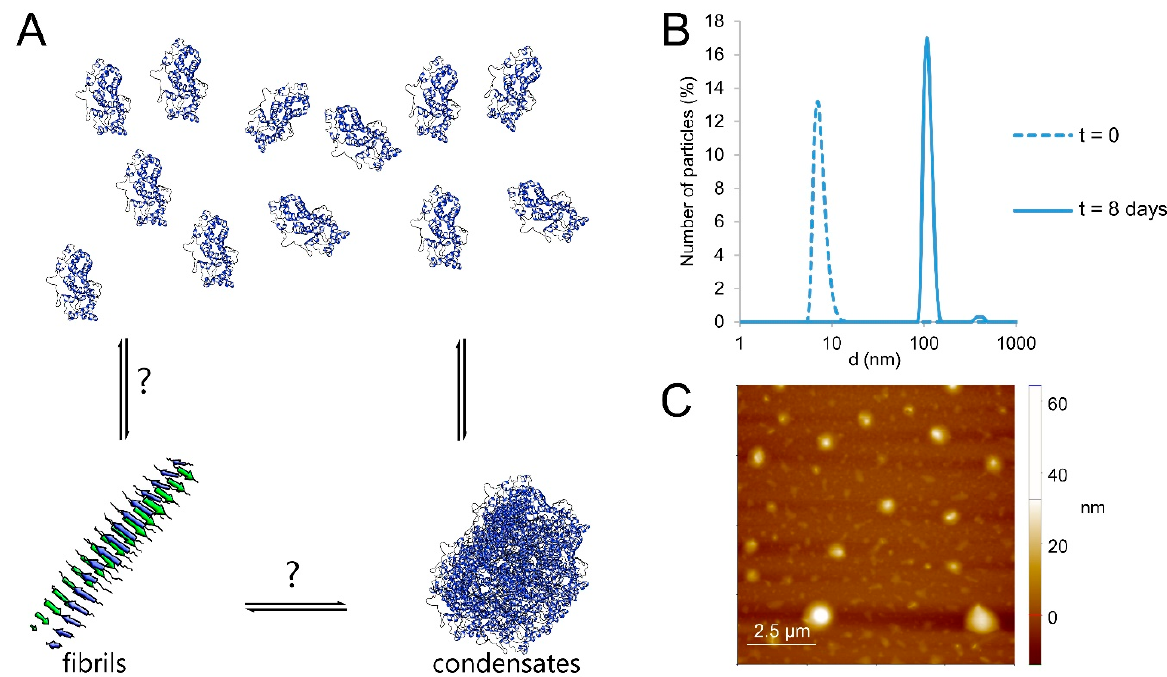
Figure 1. ( A ) Possible forms of aggregated ApoA-I, with α -helical ApoA-I in globular condensates or β -sheet rich amyloid fibril structure, both of which may be in equilibrium with the monomer. ( B ) Number-based size distribution derived using dynamic light scattering (DLS) for an ApoA-I sample directly after isolation by size-exclusion chromatography (SEC; t = 0) and after 8 days incubation at 37 °C. ( C ) AFM image of the same sample after 8 days.